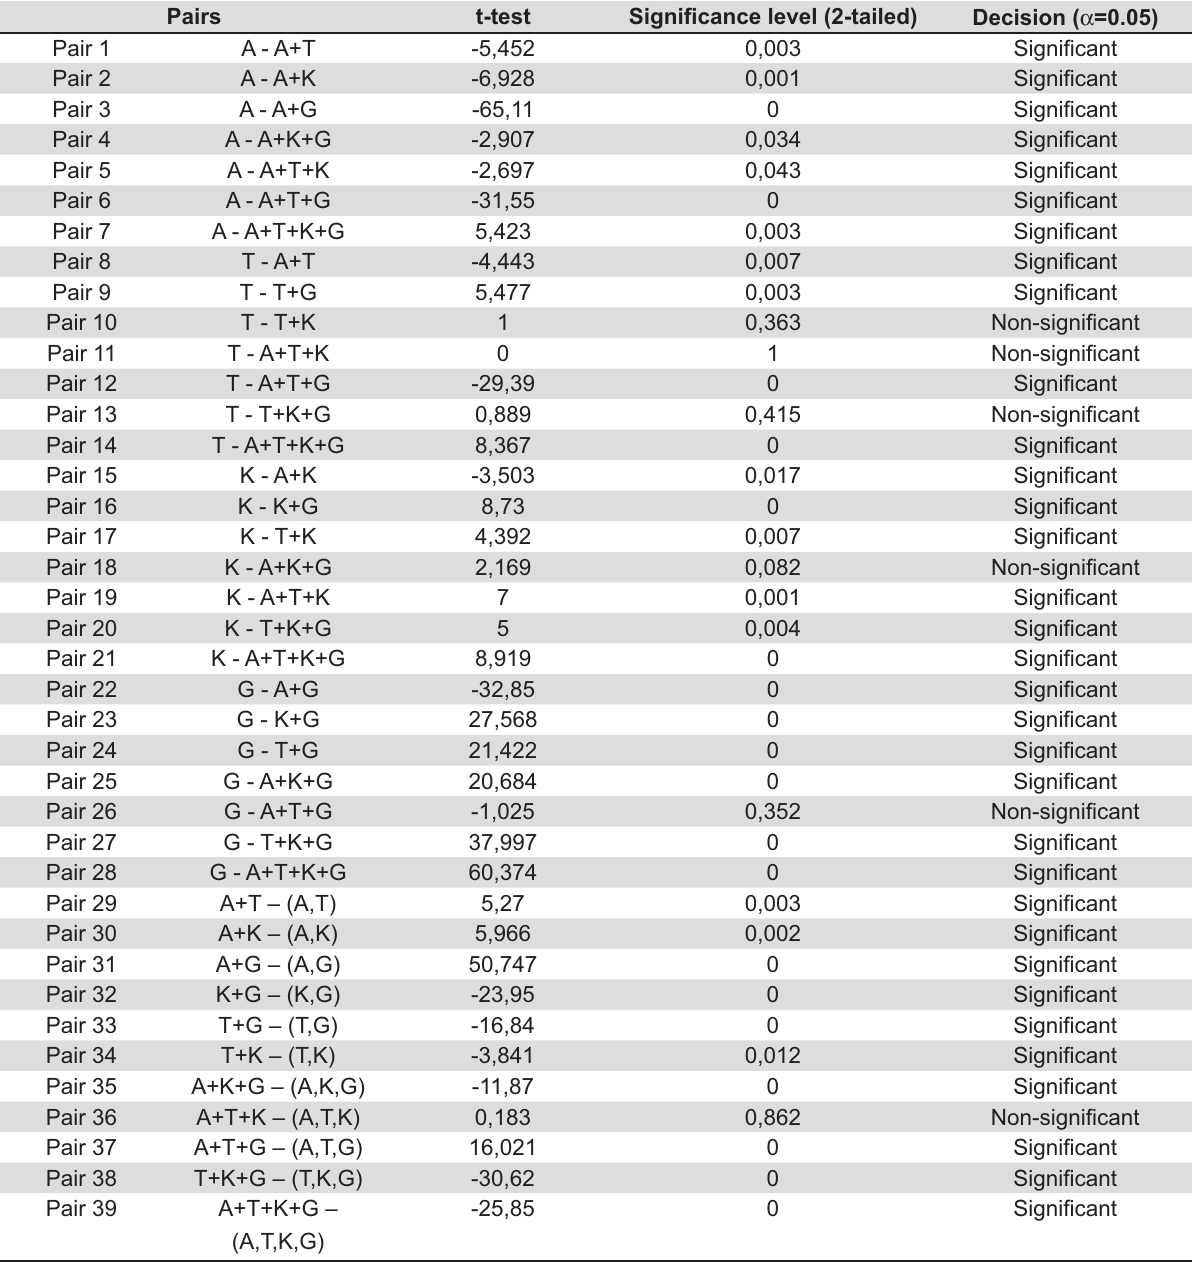
Table 1- Paired samples t-test of Candida species combinations